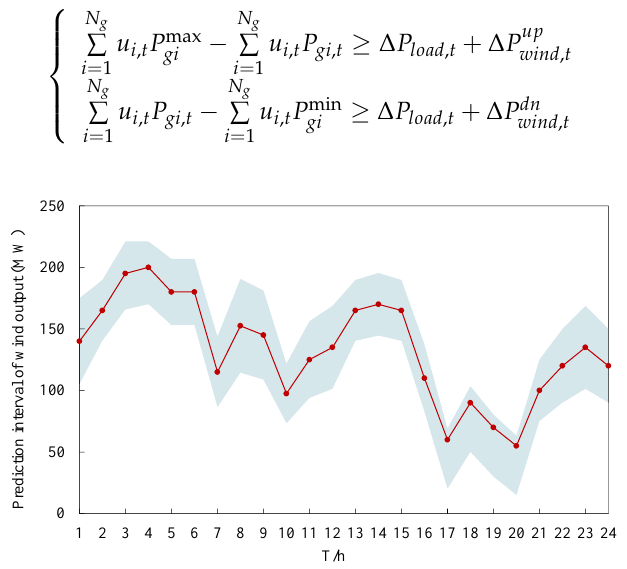
Figure 2. Prediction interval of wind output though a day.